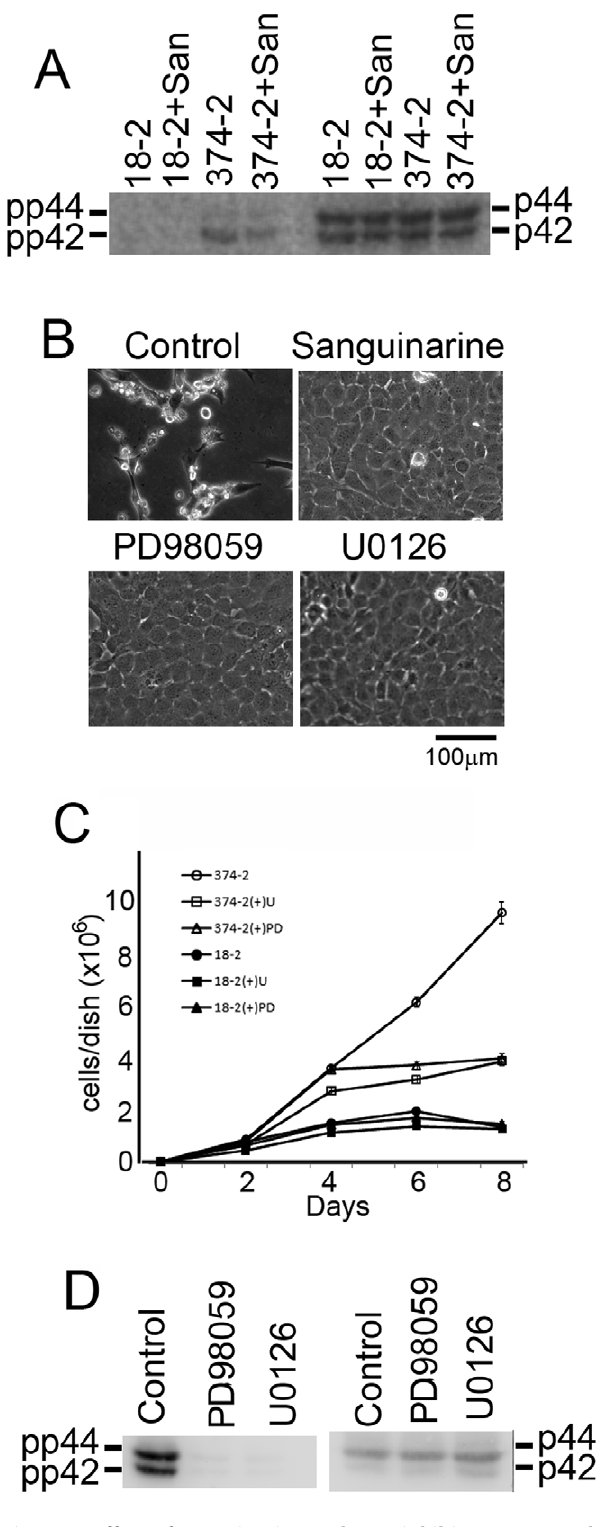
Figure 9. A model for signaling of SWAP-70-374-dependent transformation of MEFs. The putative signaling model of SWAP-70- 374-dependent transformation is shown. So far, only the role of the ERK1/2 pathway in regulation of contact inhibition is known: there should be at least one more signaling pathway responsible for fast growth of the